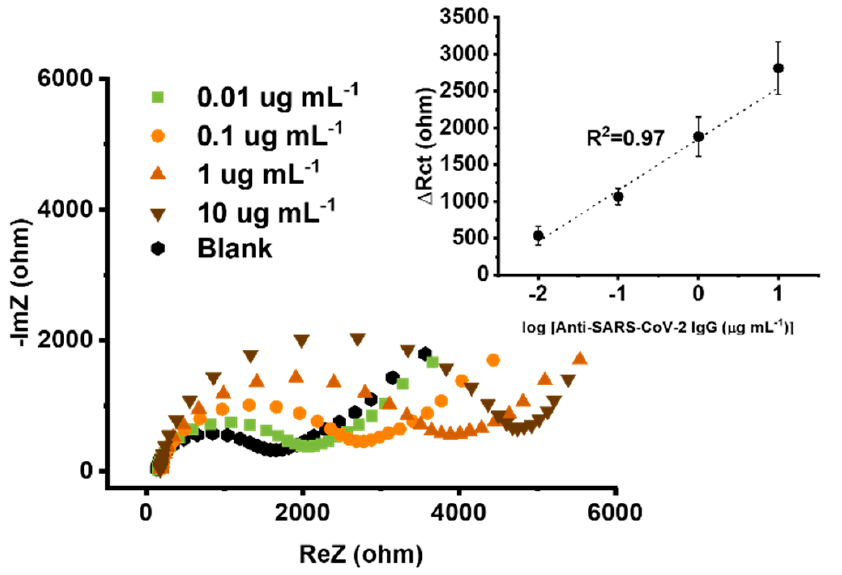
Figure 3. EIS (Nyquist plots) for different concentrations of anti-SARS-CoV-2 IgGs and the corre- sponding calibration plot in the inset (n =